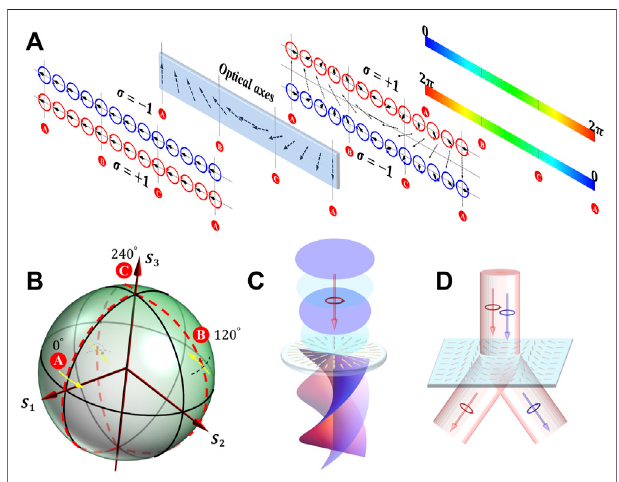
FIGURE 1 | (A) Polarization evolutions under the modulation of arti fi cial materials with spatially varying optical axes are constructed. The input and output SOPs are depicted in the fi rst and third panels, respectively; red and blue circles represent the right- and left-circular polarizations, respectively; short arrows enclosed bythesecircles arethe representations of instantaneous electric fi eld vectors (corresponding to the phase shown in the fourth panel); dash arrow lines in the second panel show the orientations of local optical axes. It is shown that the circular polarization is reversed after passing through the material, and the orientation of the instantaneous electric fi eld vectors is ordered by the orientation of local optical axes. (B) The Poincaré sphere are established to exhibit the evolution of SOP. Three evolvingroutesmarkedinredA,B,andCinthespherehighlighttheevolutions under the optical axes with orientation angles 0 ° , 60 ° , and 120 ° , respectively. As the surface area enclosed by evolving routes on the Poincaré sphere determines the change of the geometric PB phase, the fi nal phase values along these three evolving routes from the same direction are represented as Φ Φ Φ 0 ± 0 ° , 0 ± 120 ° , and 0 ± 240 ° , respectively. Yellow arrows represent the output orientation of the instantaneous electric fi eld vectors. (C) and (D) Examples of constructed PB phase devices: vortex beam generator and circularpolarizationsplitter.Shortrodsintheplatesshowtheorientationofthe local optical axes, where right- and left-circular polarizations are marked with red and blue arrows,